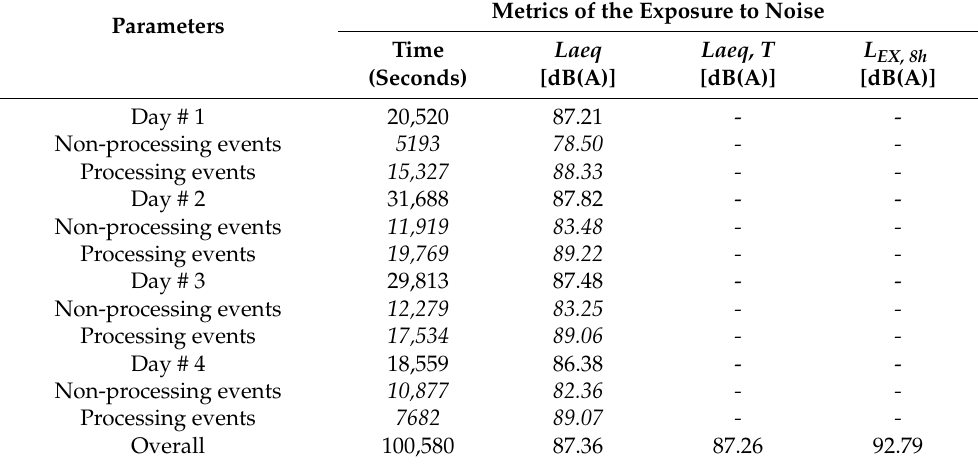
Table 3. Statistics of the exposure to